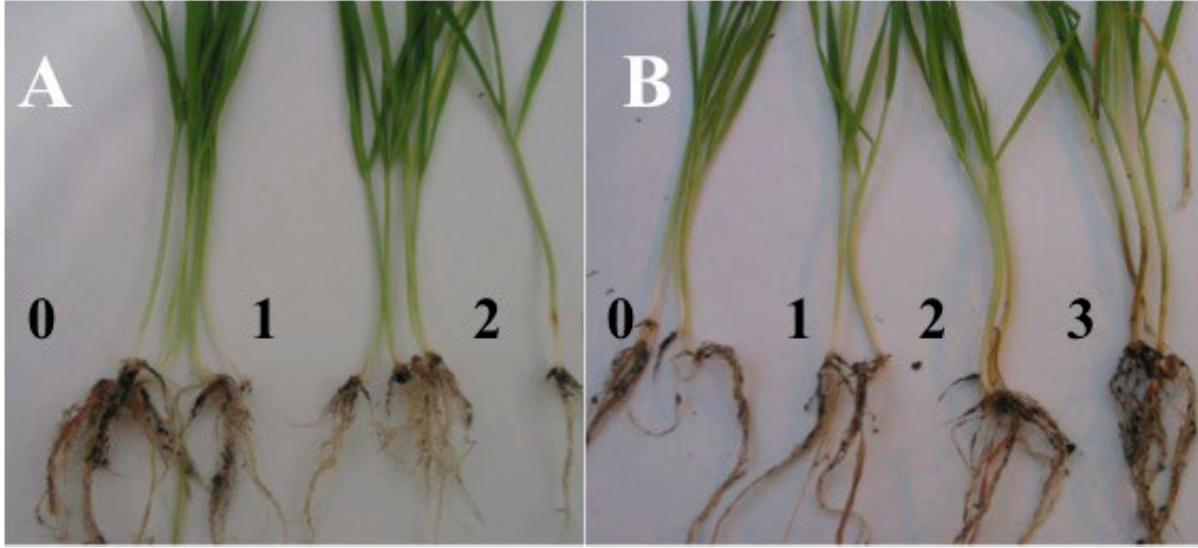
Figure 2. Different symptom severities observed in crowns and roots of durum wheat cv. Normanno 21 days after inocula - tion with Fusarium culmorum (A: strain F961; B: strain F1126).